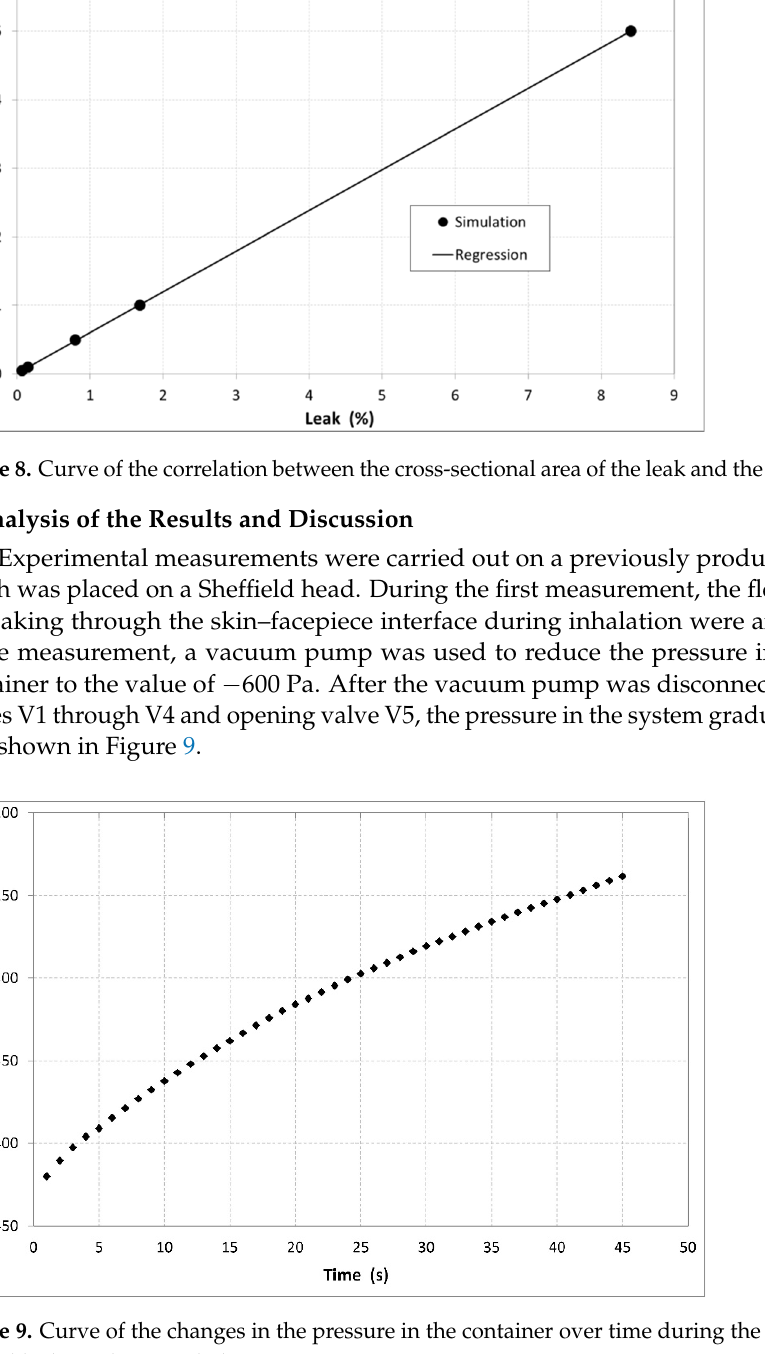
of inward leakage during inhalation. inward leakage during